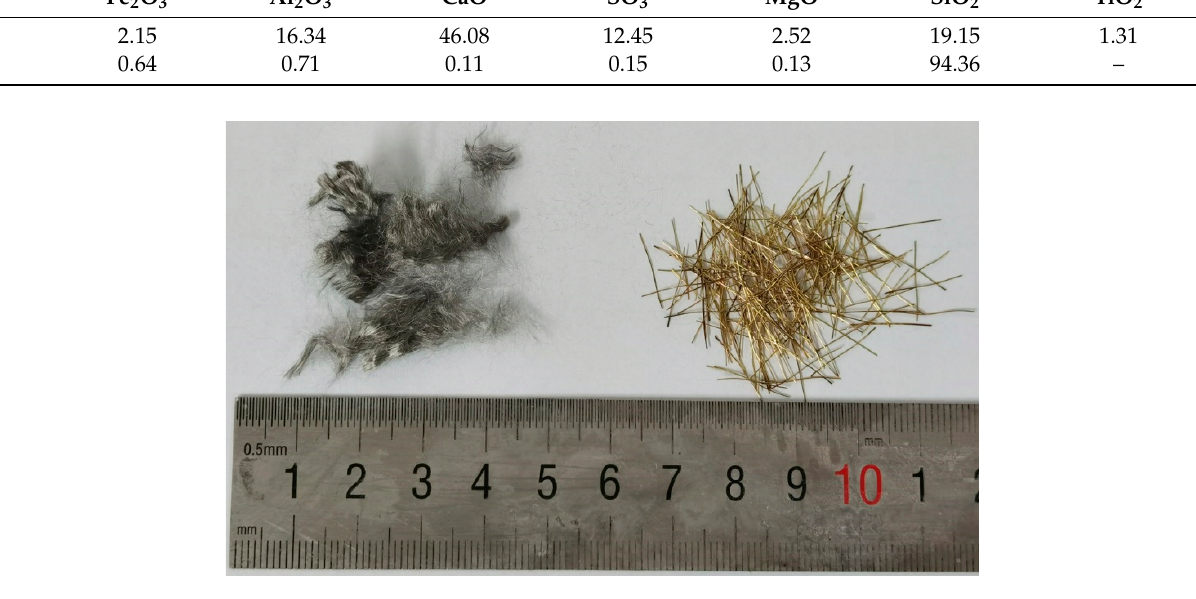
Figure 1. Morphologies of the two steel fibers.